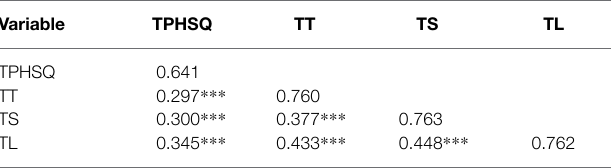
TABLE 4 | Correlation coefficient